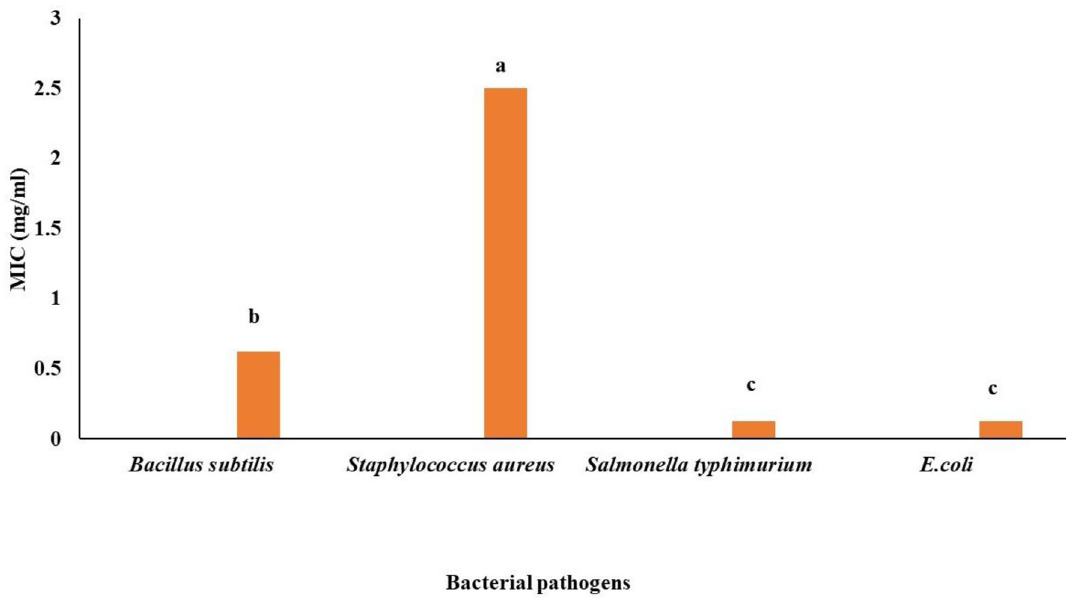
Fig 4. Minimal inhibitory concentration of Streptomyces exfoliatus strain ‘MUJA10’ against Staphylococcus aureus , E . coli , Salmonella typhumurium and Bacillus subtilis .